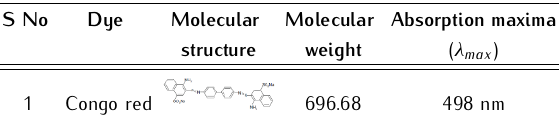
Table 1. Structure and properties of Congo